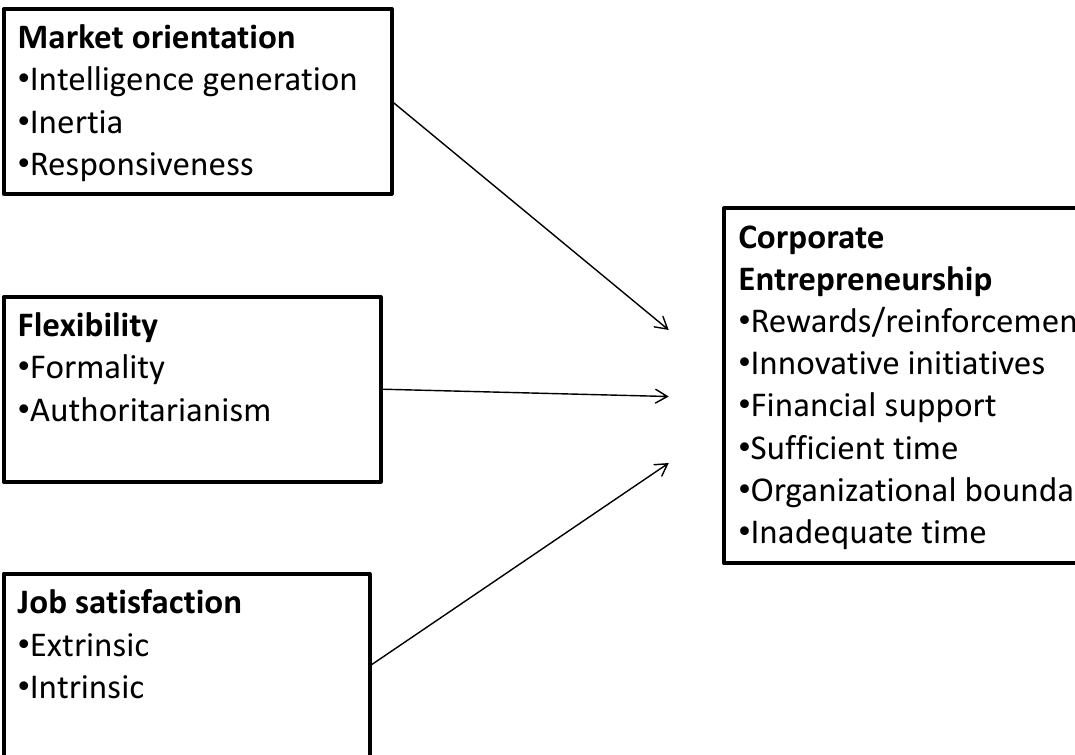
Figure 1: The relationship between the different factors of market orientation, flexibility and job satisfaction with the corporate entrepreneurial